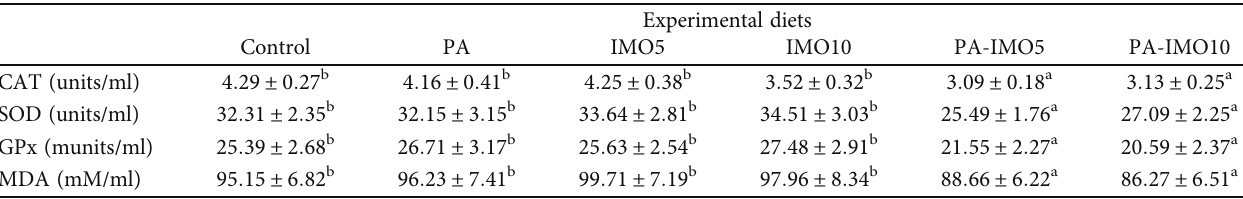
Table 5: Blood antioxidant enzyme activity and MDA value of common carp fed di ff erent levels of Pediococcus acidilactici (PA) and isomaltooligosaccharide (IMO) after 8